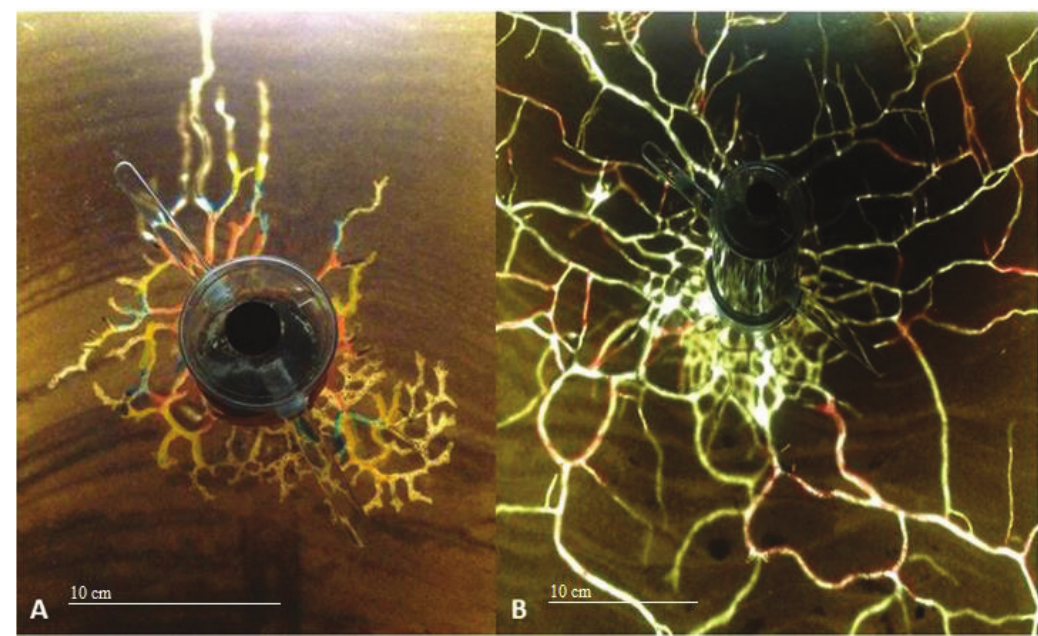
Figure 4. Tunneling performance at 20.0 °C after three days for Nylanderia fulva ( A ) and Solenopsis invicta ( B